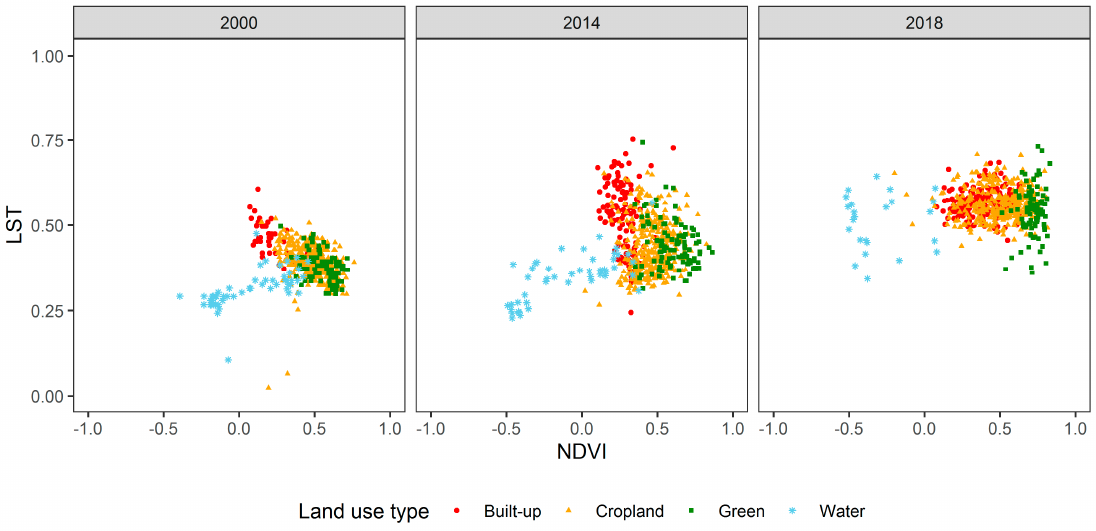
Figure 7. The space lattice of LULC-NDVI-LST in 2000, 2014 and 2018. Table 3. Statistical results of categorized LST (°C) of Nanjing in 2000, 2014, and 2018. Mean